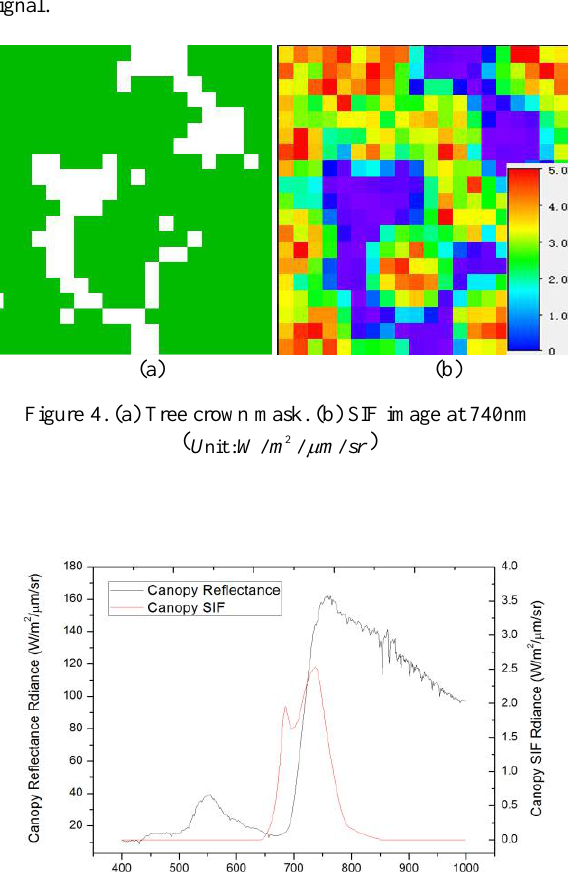
Figure 2. Forest 3-D scene: (a) Nadir view. (b) Oblique view